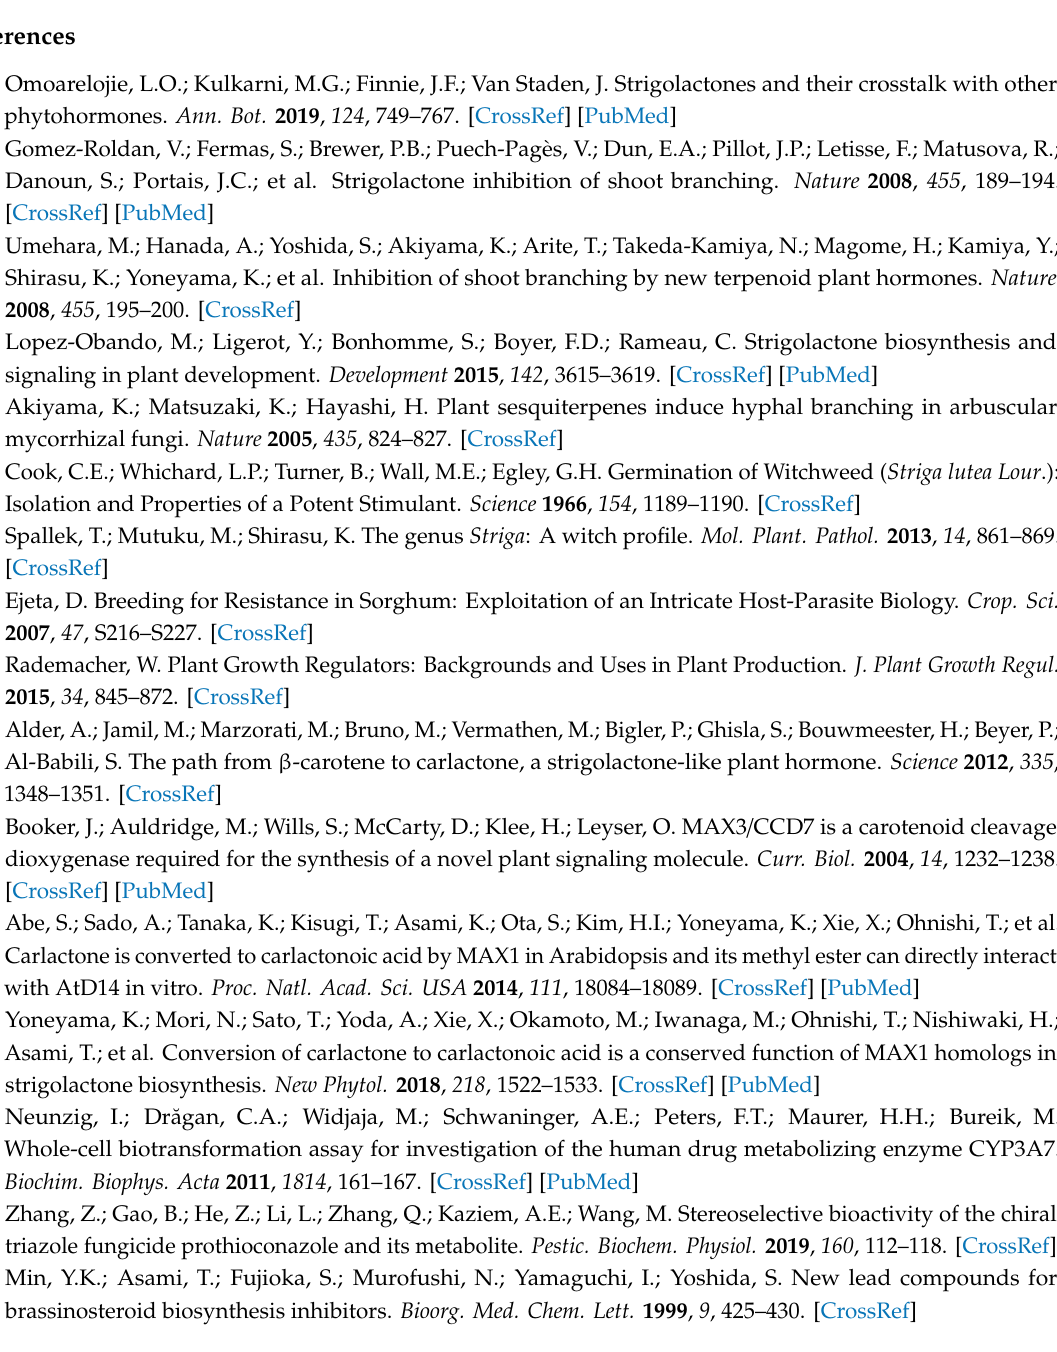
Supplementary Materials: The following are available online. Figure S1: Three groups of chemicals known as Strigolactone biosynthesis inhibitor, Figure S2: Structure of tested compounds used for screening, Figure S3: E ff ect of triflumizole on Striga germination rate, Figure S4: Pictures of Striga gemination. Author Contributions: Screening of tested compounds, Y.U. and K.K.; LC-MS / MS analysis, S.I. and K.K.; Os900 expression and enzyme assay, K.K. and T.N.; Striga germination assay, K.K. and I.T.; Experimental